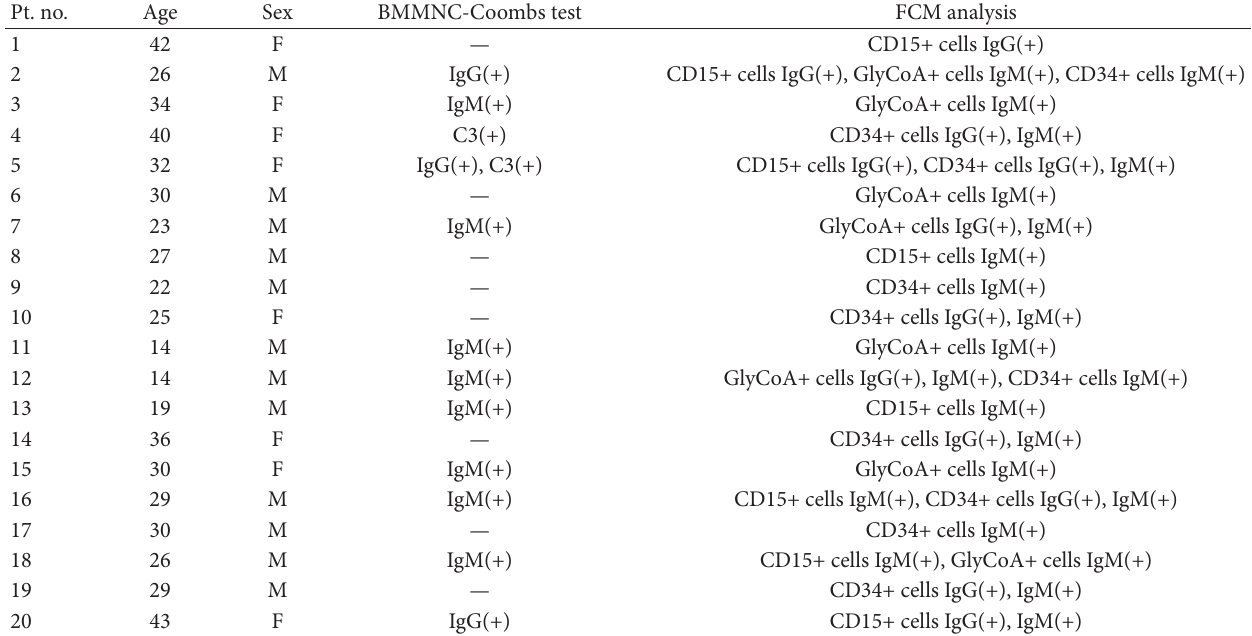
Pt. no.: patient number� Ig: immunoglobulin� FCM: �ow cytometry� GlyCoA� glycine coen�yme A� BMMNC: bone marrow mononuclear cell� F: female� M: male. �.�. ��en��������n �� �� �� �� �e�����e��� �e��s